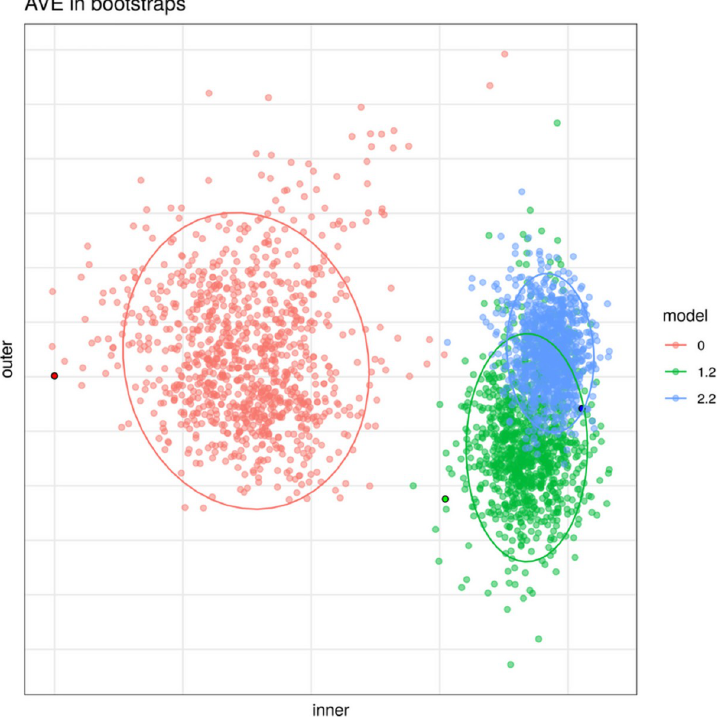
Fig 6. Bootstrap results of three models on the hematopoietic stem cell transplant Crohn’s disease dataset. Variance of AVE using the same samples on three models with the HSCT CD dataset. Each point shows the AVE for each analysis performed. The brighter colors reflect the result of this model on the original data (including all samples). Dispersion on the bootstrapped samples is reduced as a model more accurately represents the relationships present on the dataset.